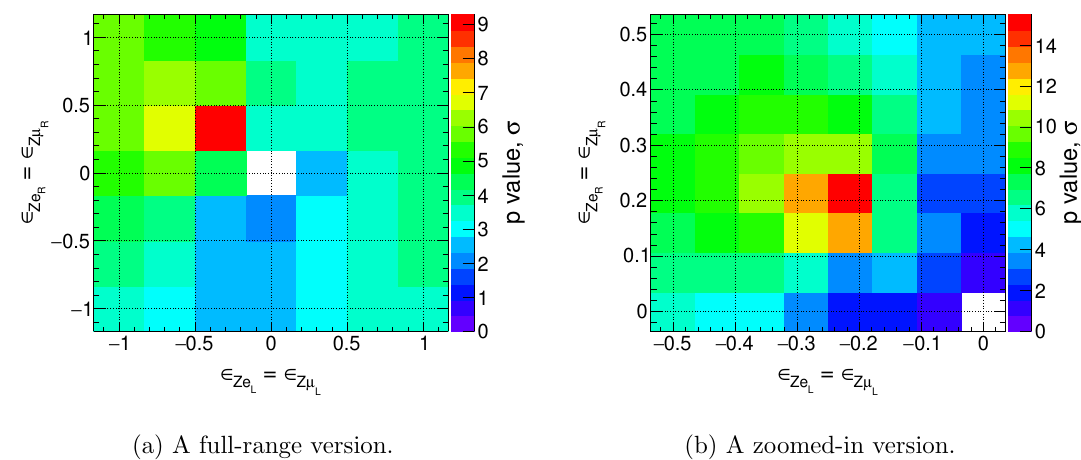
Figure 2. These (cid:12)gures show the expected discovery sensitivity in sigma (with 100 fb (cid:0) 1 at 13 TeV) for the hypothesis described in scenario 4, where, in addition to the SM coupling, the PO (cid:15) Z‘ (cid:15) Ze = (cid:15) Z(cid:22) and (cid:15) Z‘ = (cid:15) Ze = (cid:15) Z(cid:22) take on non-zero values. These quantities are speci(cid:12)ed L L R R R on the x and y axes; the SM is re(cid:13)ected by the point (0 ; 0). The (cid:12)gure on the right, (cid:12)gure 2b, gives a zoomed-in version of the second quadrant of (cid:12)gure 2a. The results are obtained using only the kinematical distribution of the events via the procedure speci(cid:12)ed in subsection 3.3. Including information about the relative normalization of the various H ! 4 ‘ channels has a relatively small impact here.